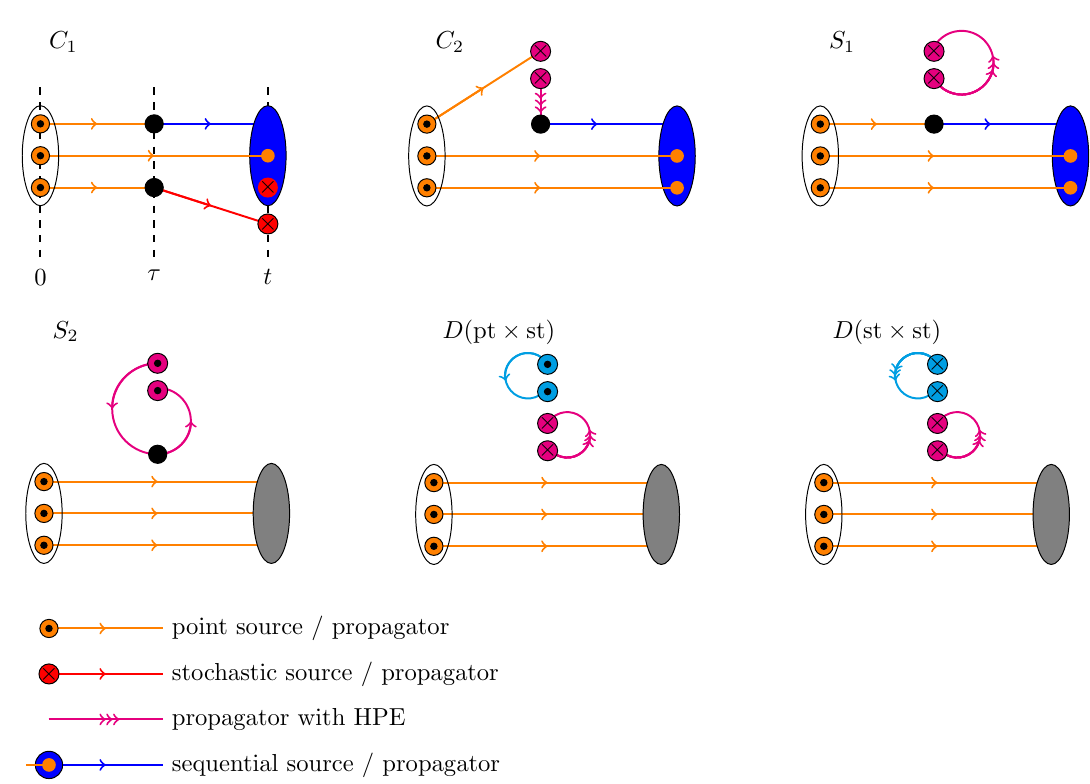
Figure 4 . Sketch of all Wick contractions including the techniques used for the evaluation of each piece on the lattice. We use one color for each involved quark source, i.e. if two or more pieces within a graph share the same color, they involve the same quark source. Colors have no meaning regarding the evaluation technique. There are two versions of the D graph: in the first we use two stochastic loops (bottom right), whereas in the second (bottom center) one stochastic loop is replaced by a point source